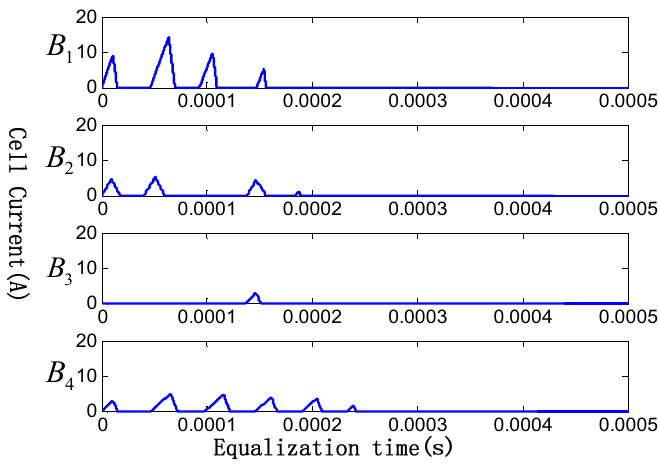
Figure 13. Cell voltages during discharging state.